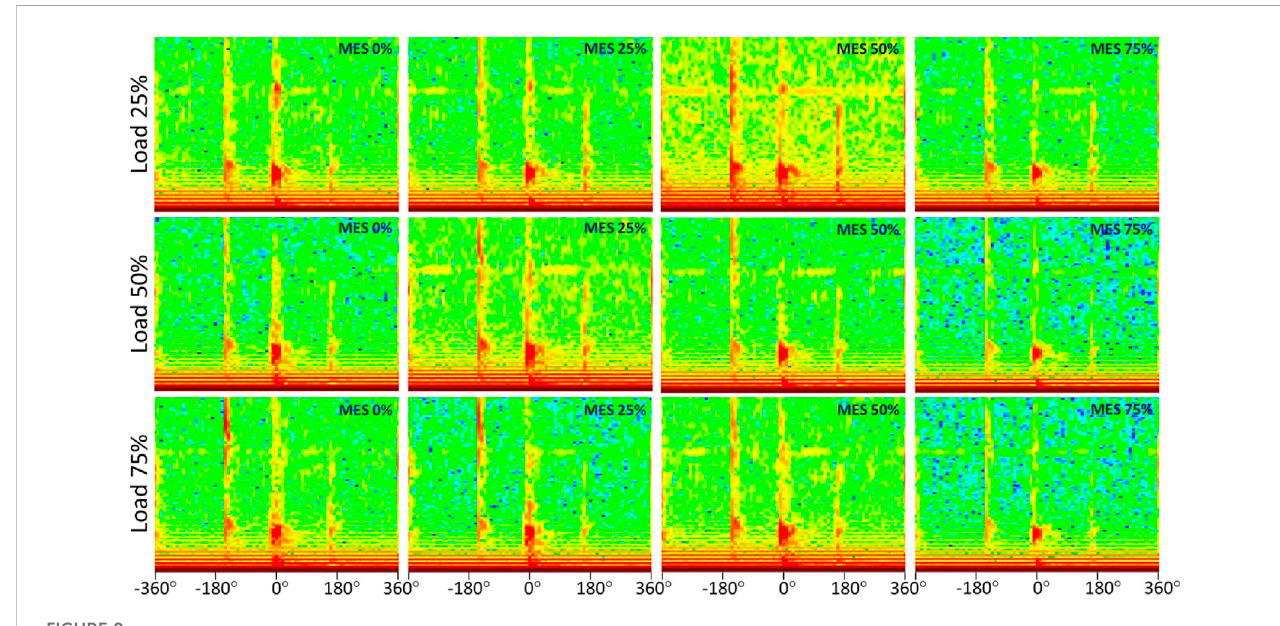
FIGURE 9 20 kHz frequency pulsations for different methane share and